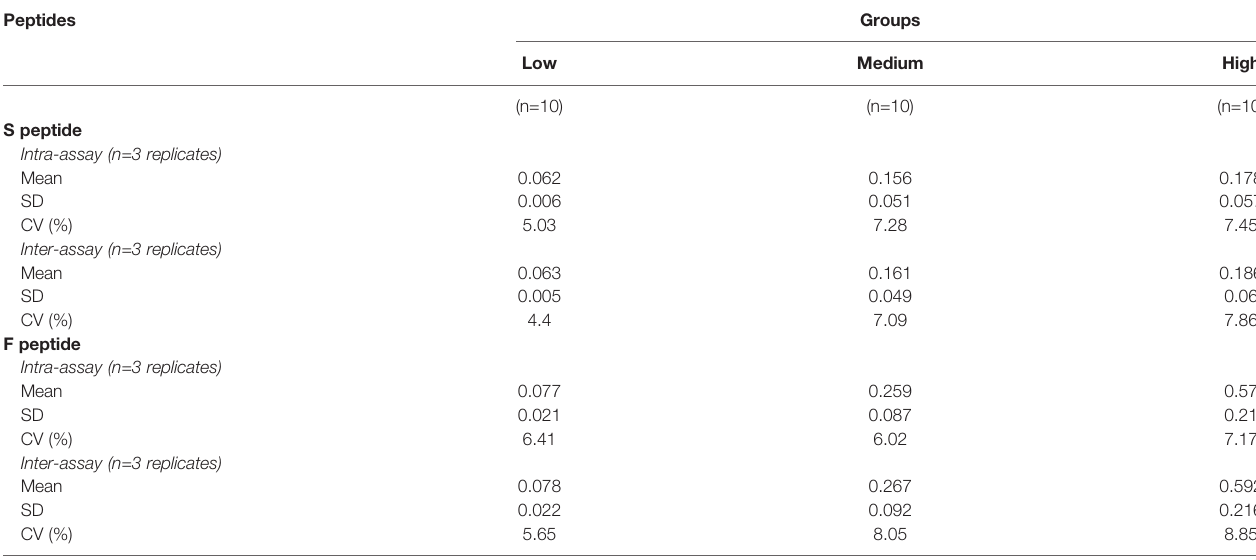
TABLE 2 | Indirect ELISA intra-assay and inter-assay coef fi cient of variations (CVs). Peptides Groups Low